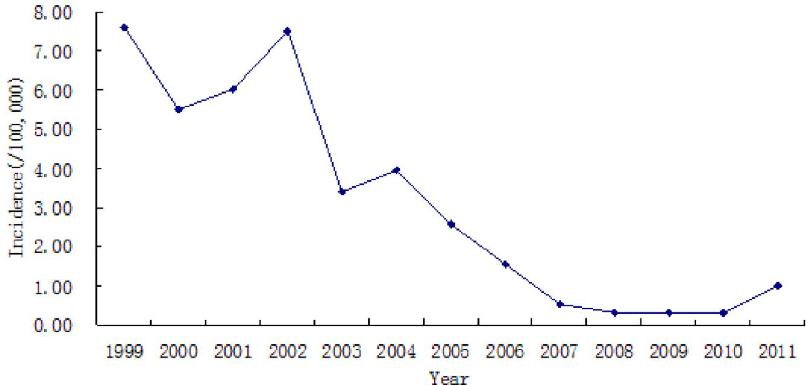
Figure 2. The incidence of HFRS in Hebei province from 1999 to 2011.